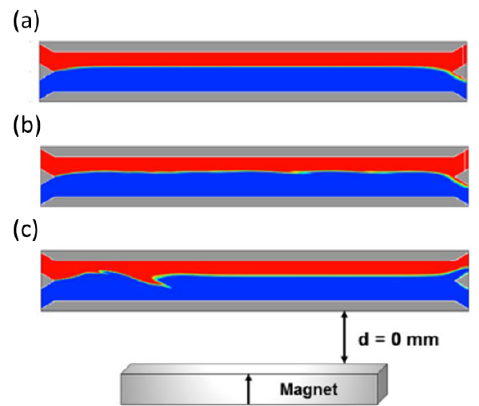
Figure 6. Flow patterns (blood in red, aqueous buffer in blue) simulated by Gomez-Pastora et al. [33] showing the effect of the bead motion on the fluid flow while the particles are magnetically separated. Reproduced with permission from Gómez-Pastora, J.; Karampelas, I.H.; Bringas, E.; Furlani, E.P.; Ortiz, I, Numerical analysis of bead magnetophoresis from flowing blood in a continuous-flow microchannel: Implications to the bead-fluid interactions; published by Sci, 2019. ( a ) One-way coupling model. ( b ) Two-way coupling model. ( c ) Two-way coupling accounting for the effects of bead volume.